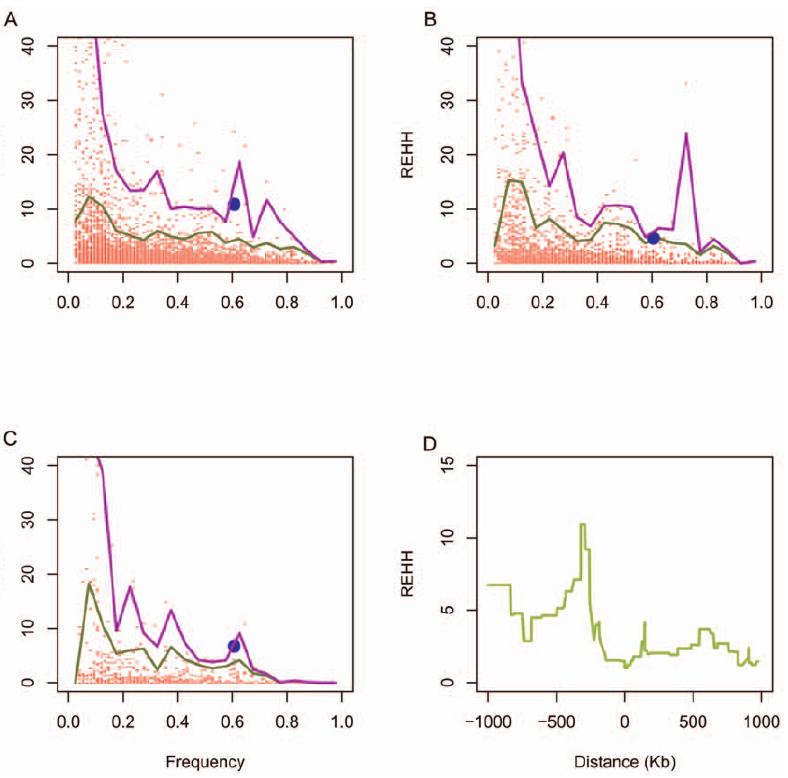
Figure 6. REHH of the core haplotypes on chromosome 20 and GDF5 . REHH distributions at (A) 300 kb, (B) 500 kb, and (C) 1000 kb upstream and downstream of the core haplotypes. The two lines represent the 99% and 95% percentile rank values. Big dots are the major haplotype at the GDF5 gene. (D) REHH of the major core haplotype at the GDF5 gene at varying physical distances (kb).